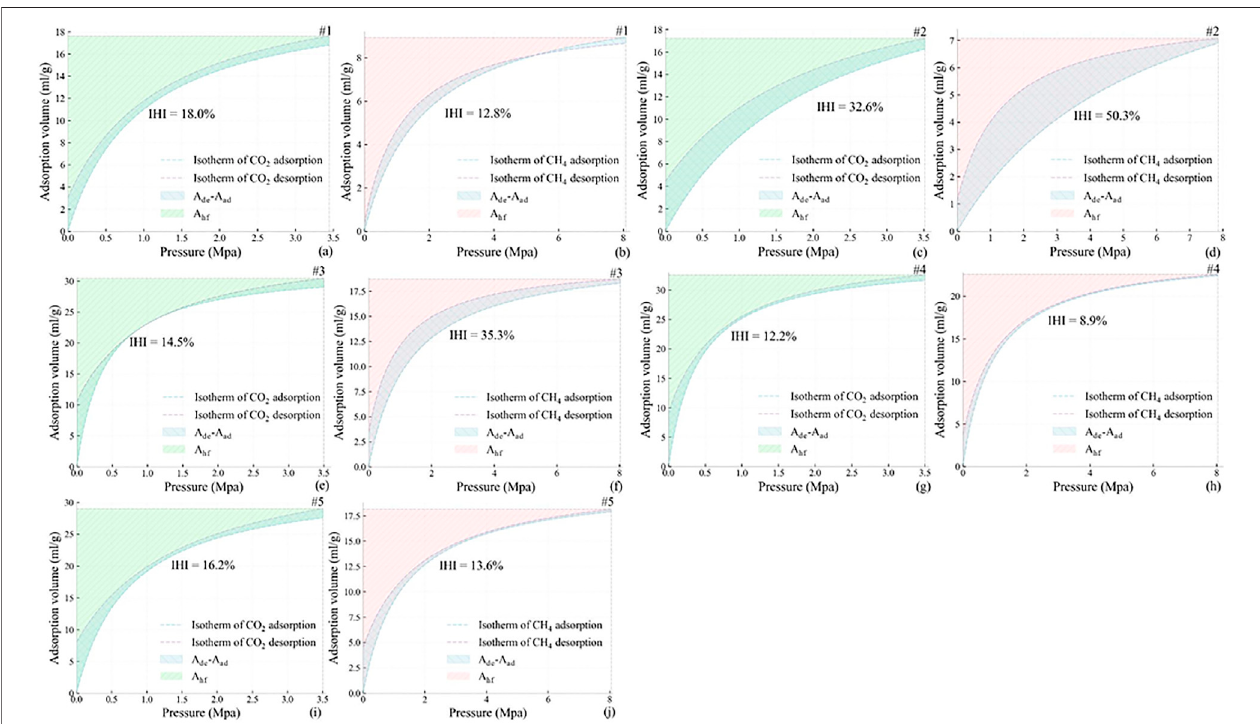
FIGURE 6 | IHI calculation. (A) , (C) , (E) , (G), and (I) represent CO 2 IHI calculation; (B) , (D) , (F) , (H), and (J) represent CH 4 IHI calculation.